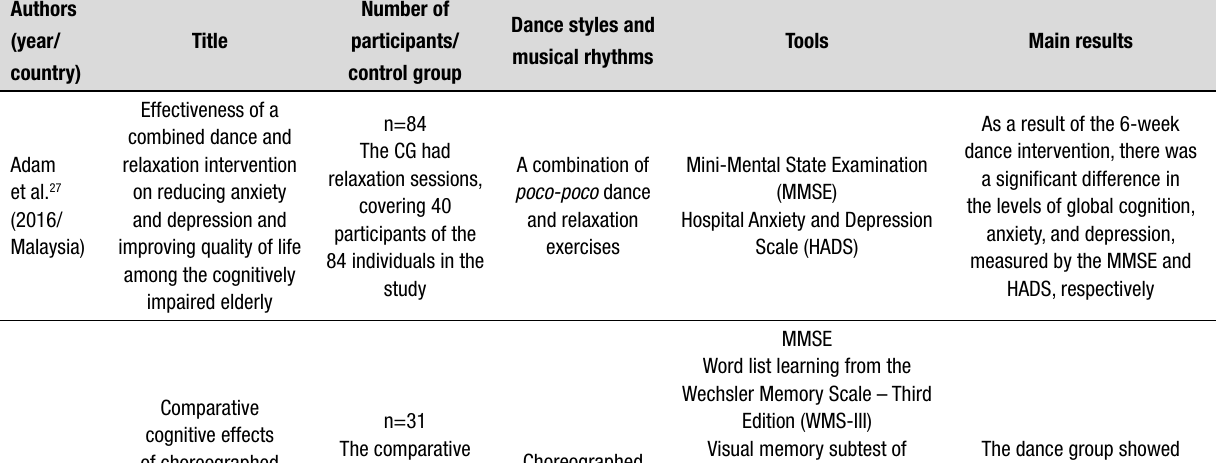
Table 1. Main results of included